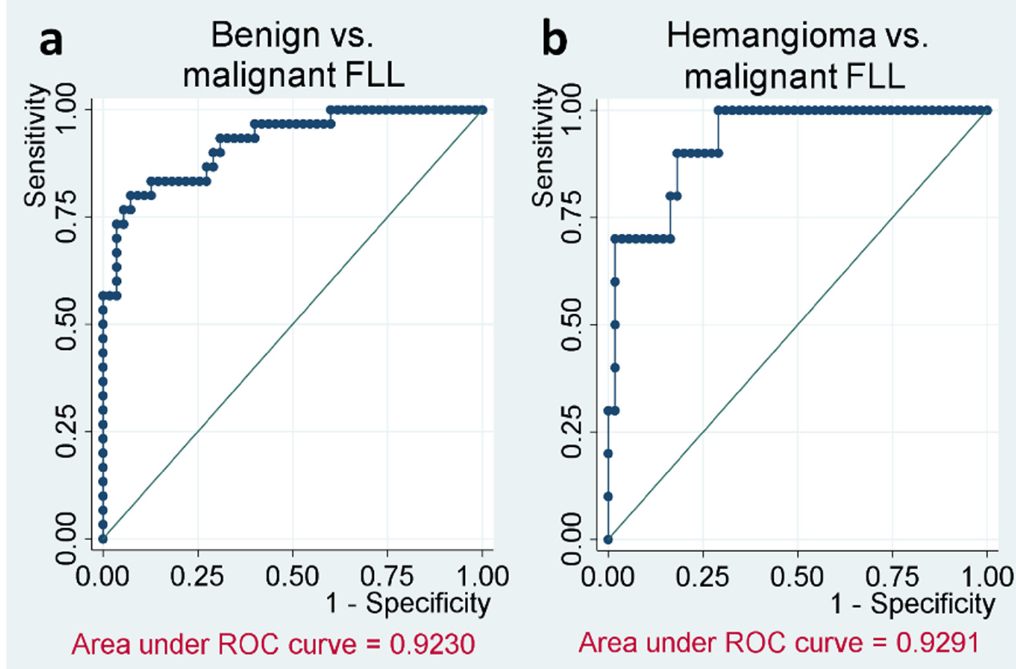
Figure 6. Rise time and late phase ratio combined in logistic regression ( X axis: 1-Specifity; Y axis: Sensitivity). ( a ) The combination of parameters differs well between benign lesions and malignancies. The area under ROC curve is 0.923. ( b ) The combination of parameters differs well between hemangiomas and malignancies. The area under ROC curve is 0.929.